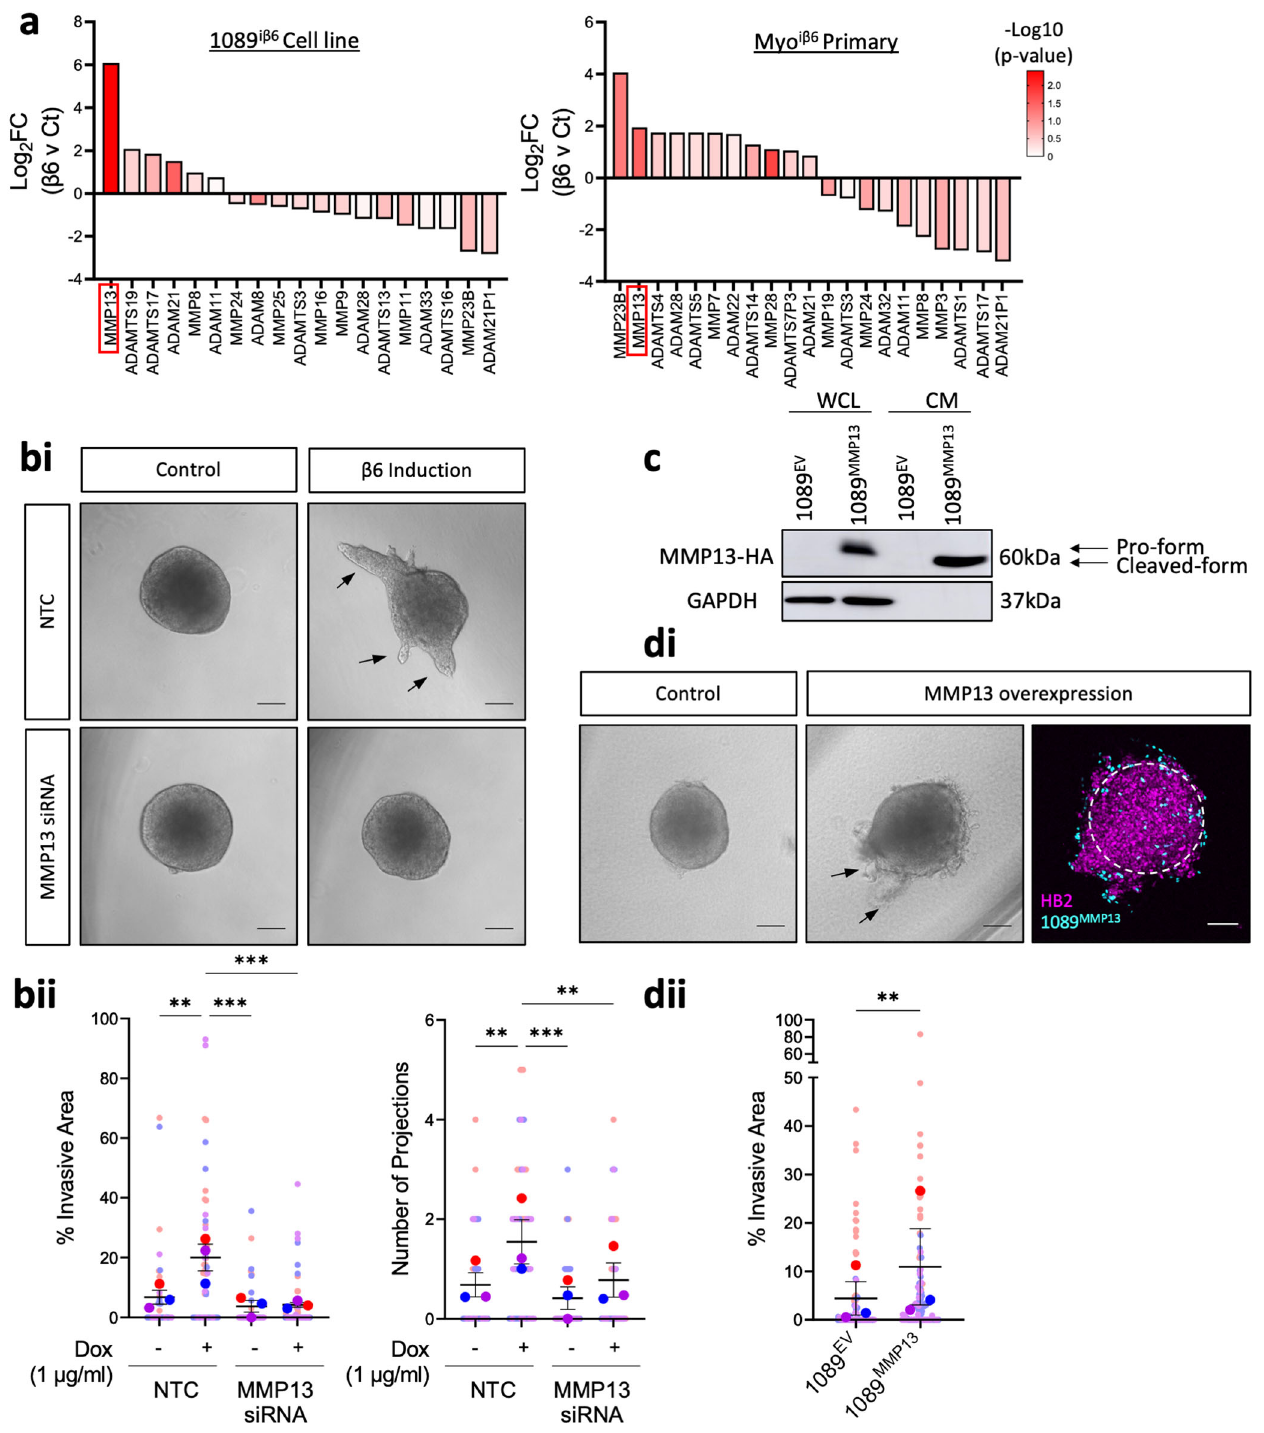
Fig. 3 β 6 drives upregulation of MMP13, which facilitates invasion. a Changes in protease mRNA expression following β 6 induction in 1089 i β 6 cell line (left) and Myo i β 6 primary cells (right). Data are representative of two independent experiments. bi Representative light micrographs of HB2/1089 i β 6 spheres transfected with either non-targeting control (NTC) or MMP13 siRNA 4 days post doxycycline (1 µg/mL) treatment. bii Summary graphs showing percentage of invasive area and number of projections across conditions. c Western blot of MMP13- HA tag in whole cell lysate (WCL) and conditioned media (CM) of 1089 cells transfected with MMP13-HA pLenti-construct (1089 MMP13 ) or empty vector (1089 EV ). di Representative light micrographs and ( dii ) summary graph showing percentage of invasive area and number of projections in HB2/1089 MMP13 spheres. Data are presented as mean ± SEM, where each dot represents one sphere with biological replicates indicated by different colours. Average of biological replicates indicated as larger-sized points. ** p < 0.01, *** p < 0.001 (Kruskal – Wallis Test with multiple comparisons or Mann – Whitney U Test). Data are representative of three independent experiments. Scale bar = 100